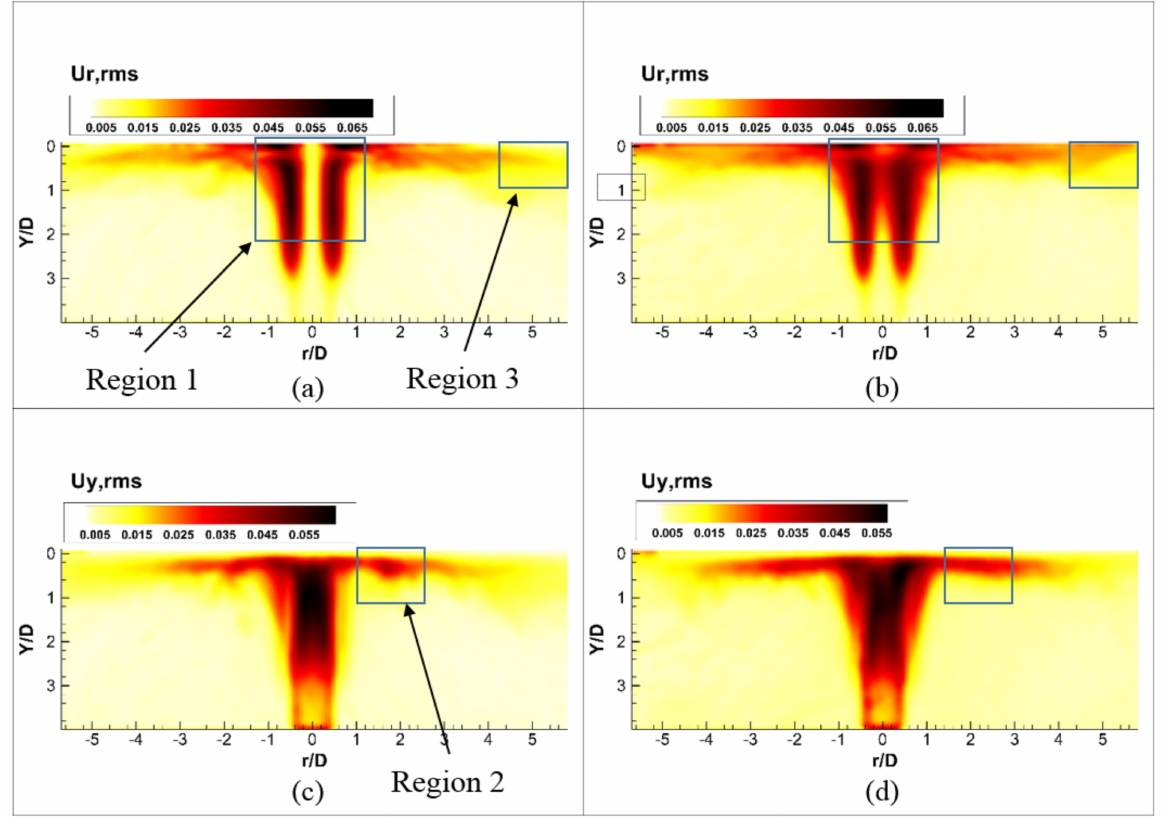
Figure 3. Turbulence intensities distribution for ( a , c ) stationary and ( b , d ) rotating